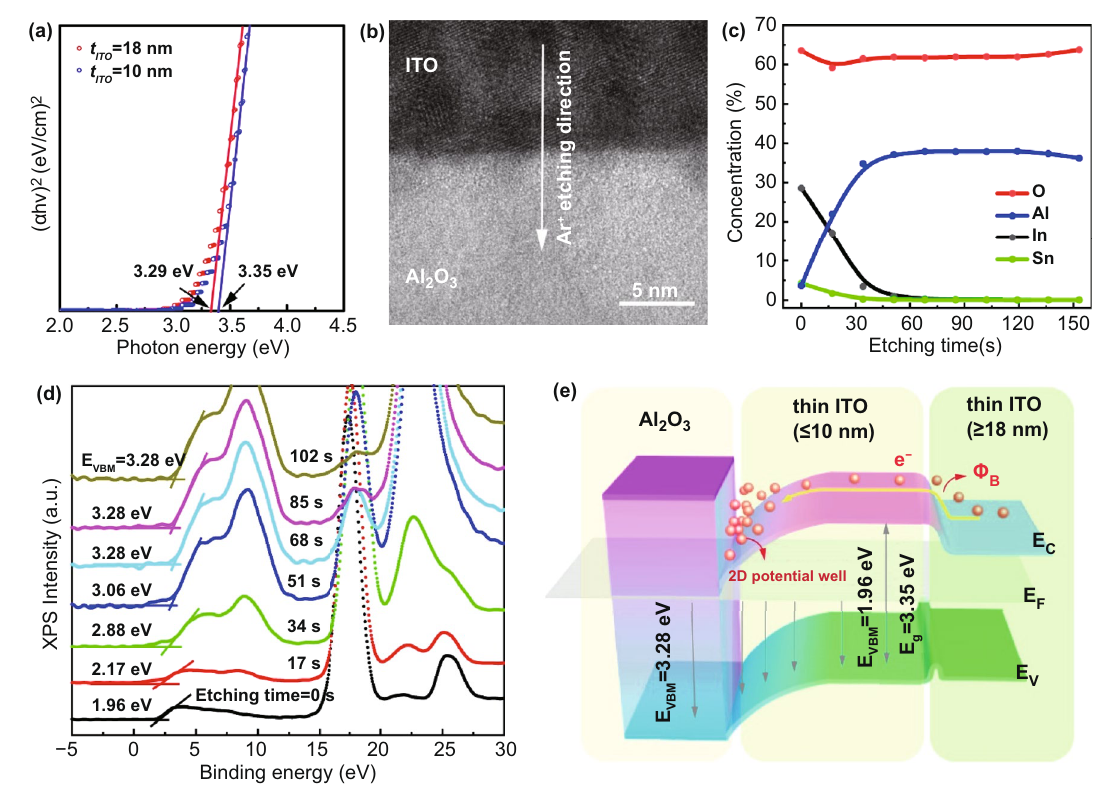
Fig. 4 Energy band analysis of ITO/Al 2 O 3 interfaces. a Tauc plots of ITO films with different thicknesses of 10 and 18 nm. b Cross-sectional TEM image of ITO/Al 2 O 3 interface. The arrow indicates the Ar etching direction (from top ITO to bottom Al 2 O 3 ). c Elemental concentration of In, Sn, Al, and O in the ITO/Al 2 O 3 films as a function of etching time, extracted from the XPS depth profiles. d Depth-resolved VBM spec- tra based on in-situ XPS measurements with different Ar etching time. The VBM energy increased gradually from 1.96 eV of ITO surface and became stable at 3.28 eV of bulk Al 2 O 3 . e Energy band diagram of the thick ITO/thin ITO/Al 2 O 3 heterostructure reconstructed based on UV–Vis and XPS depth spectra. The band bending at the ITO/Al 2 O 3 interfaces induced a 2D potential well confining free electrons. And a barrier Φ B exists at ITO channel and electrode layers due to the difference in